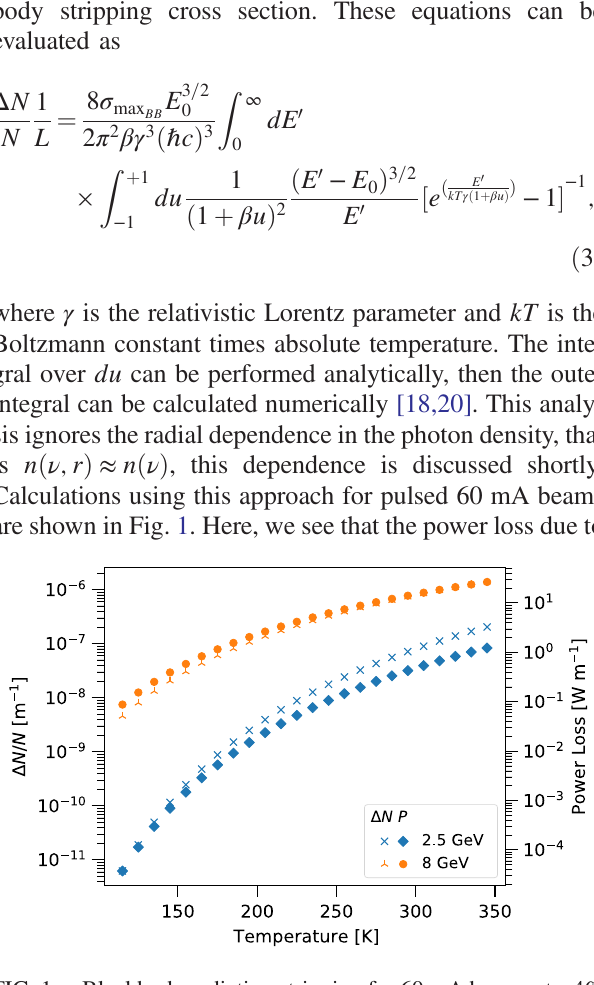
FIG. 1. Blackbody radiation stripping for 60 mA beams at a 4% duty cycle for 2.5 and 8 GeV. Markers in the left- and right-hand columns of the legend correspond to fractional loss rate and corresponding beam power loss,